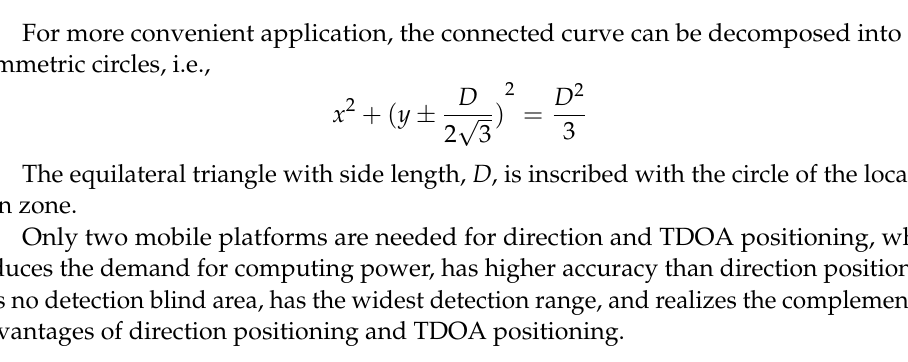
Figure 5. Range of direction and time difference